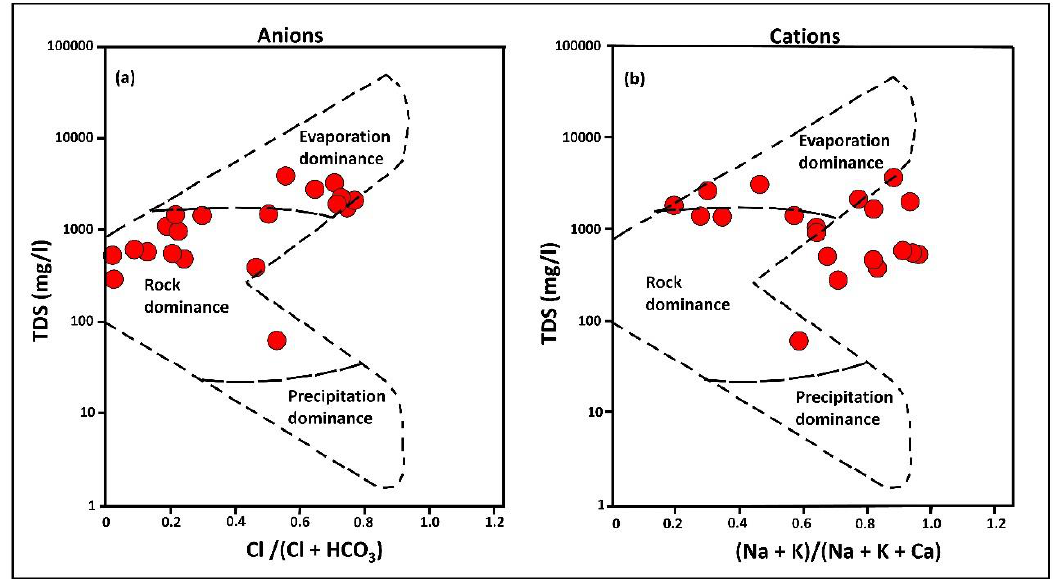
Figure 6. Gibbs plots showing ( a ) Total Dissolved Solids (TDS) vs. Cl / Cl + HCO 3 and ( b ) TDS vs. Na + K / (Na + K + Ca) to illustrate the dominant processes governing groundwater chemistry in Makueni County.